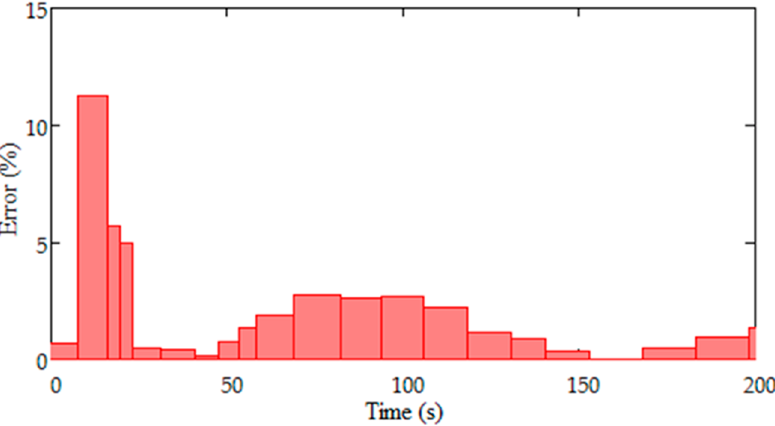
Figure 8. The percentage error in time between the experimental and numerical data. For the second experiment, the model is shown in Figure 9. Heat flow was applied to the left sinus face of shield 1 where the temperature is denoted by T 1. The right surface of shield 1 exchanged heat by radiation with the left sinus face of shield 2.